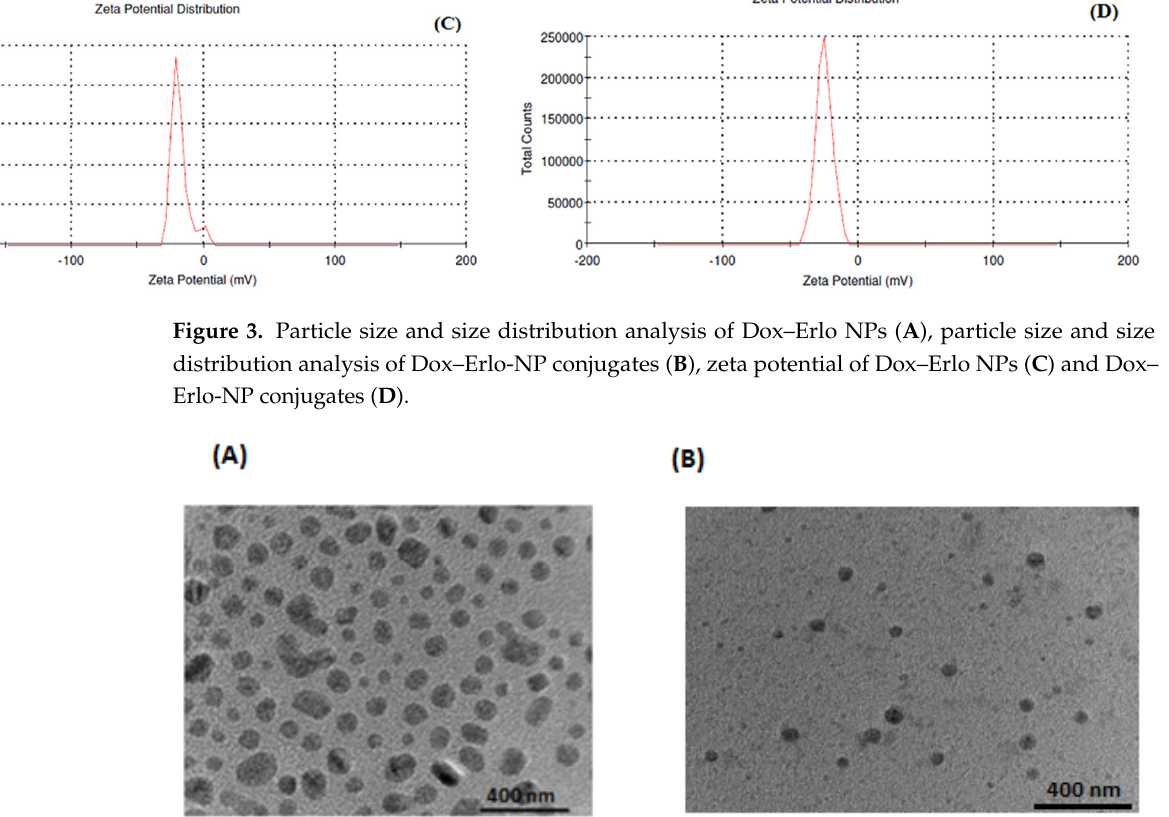
Figure 5. DSC thermogram of Erlo (A), cinnamon biopolymer (B), polyvinyl alcohol (C), Dox–Erlo NPs (D), and Dox–Erlo-NP conjugates (E). 2.5.3. FT-IR Spectral Analysis FT-IR spectroscopy characterized the chemical stability of NPs encapsulated in the core of the biopolymer. The FT-IR spectra of Erlo, biopolymer, polyvinyl alcohol, Dox– Erlo NPs, and Dox–Erlo-NP conjugates are indicated in Figure 6. The structure of Erlo shows a 2-methoxy ethoxy group (C-O stretching) and amino-group (N-H stretching) of quinazoline ring. The biopolymer demonstrated a peak around 2743.12 cm − 1 , and 2918.33 cm − 1 belongs to the carboxylic acid group. The Erlo drug demonstrated absorption bands at 3267.14 cm − 1 , corresponding to N-H stretching, and at 1081.18 cm − 1 , attributed to C-O stretching (Figure 6).